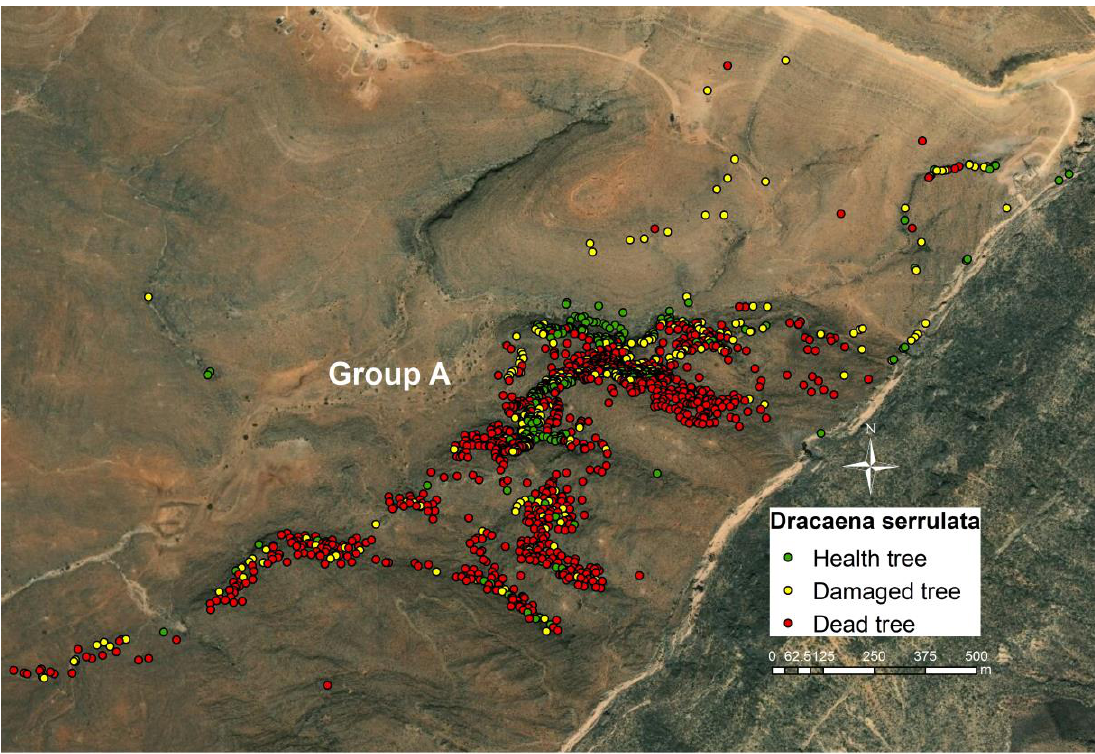
Figure 6. Inventory of Dracaena serrulata at the upper plateau of Jabal Samhan. Group A in the analysis.Background: ESRI base maps (Redlands, CA, USA).